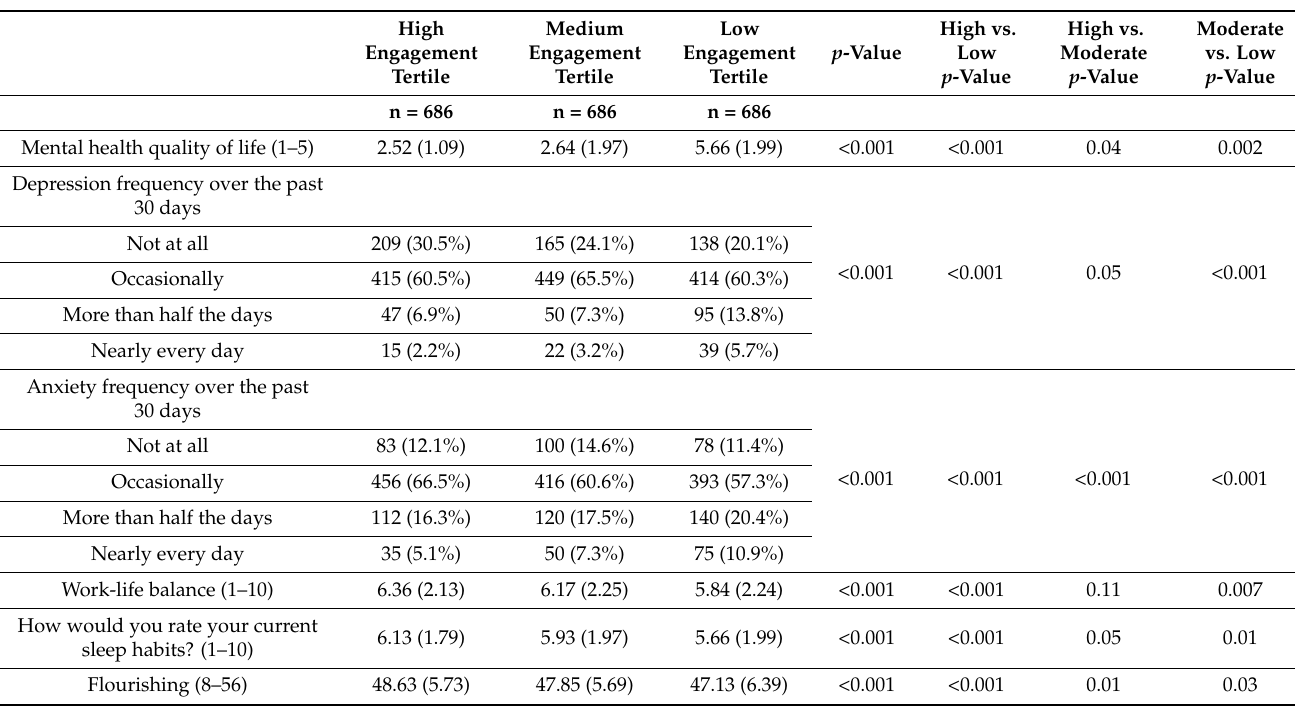
Table 3. Psychosocial characteristics by engagement at weeks 5 and 17 ( n =